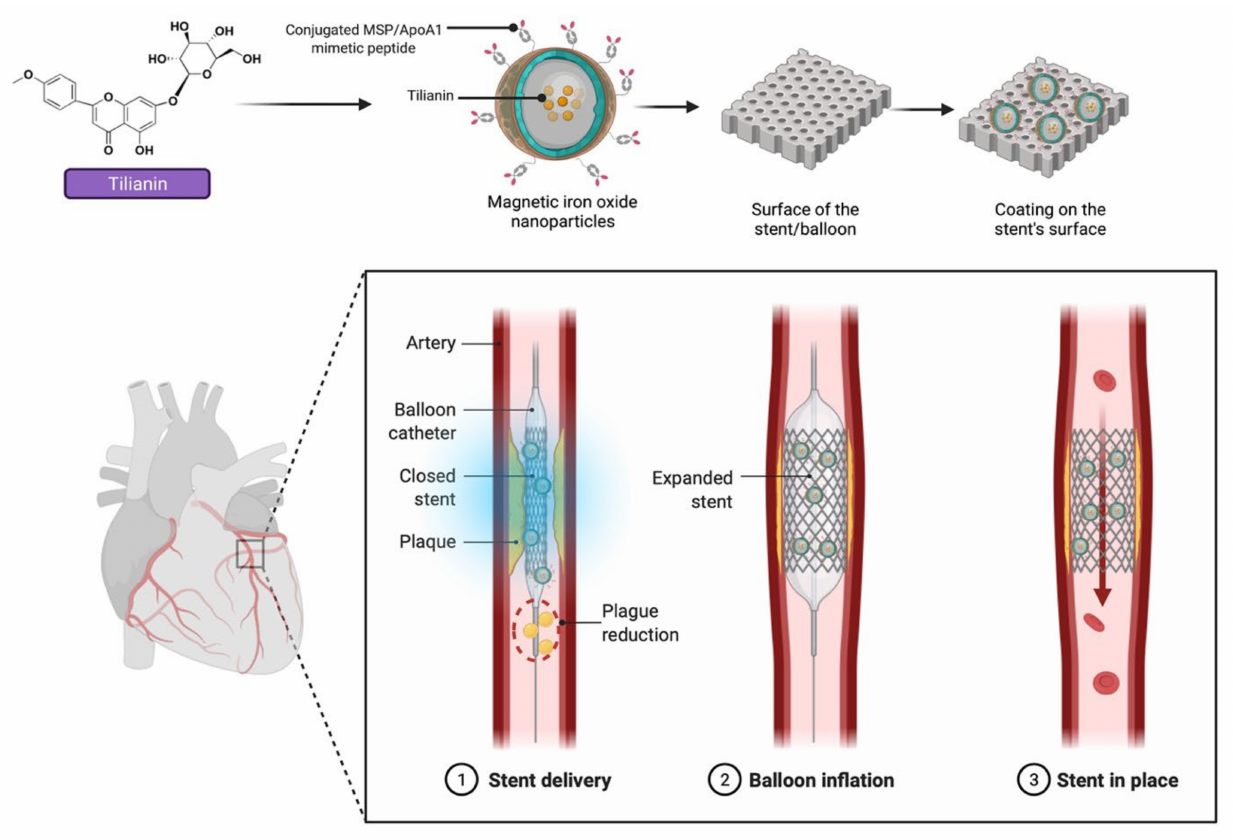
Figure 10. Tilianin-loaded magnetic iron oxide nanoparticles augmented with surface decorated MSP/ApoA1, deposited onto the surface of the stent/balloon for in situ targeting approach for effective plague reduction activities in the